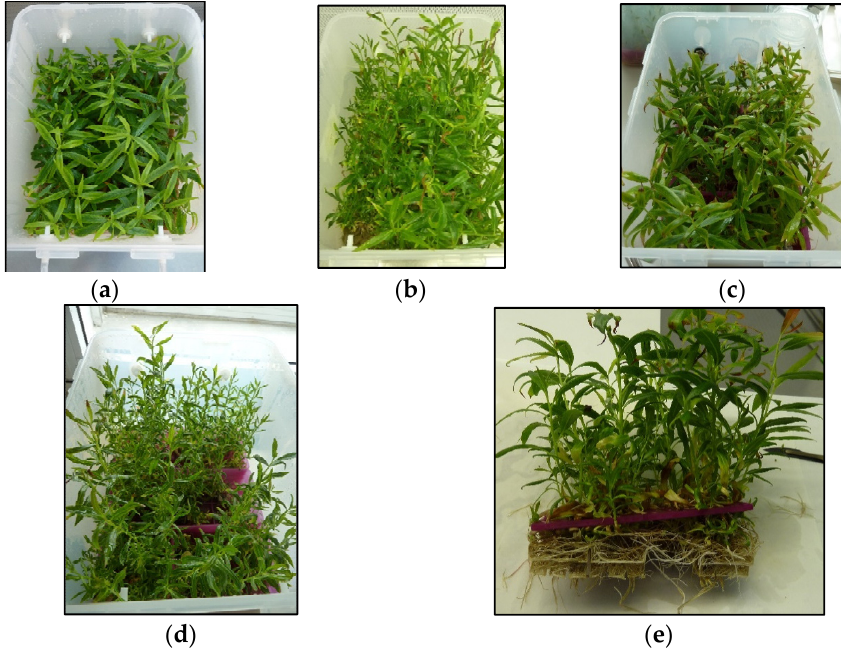
and handle them in the laminar flow cabinet during subculturing (Figure 5e).